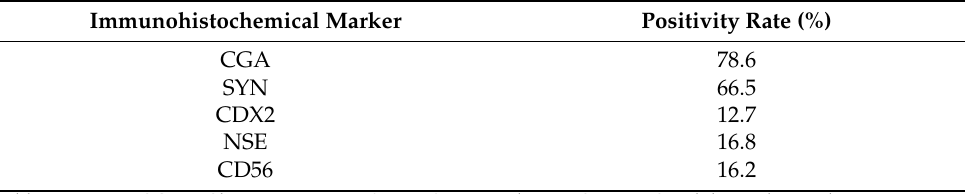
Table 2. Positivity rate for neuroendocrine immunohistochemical markers.